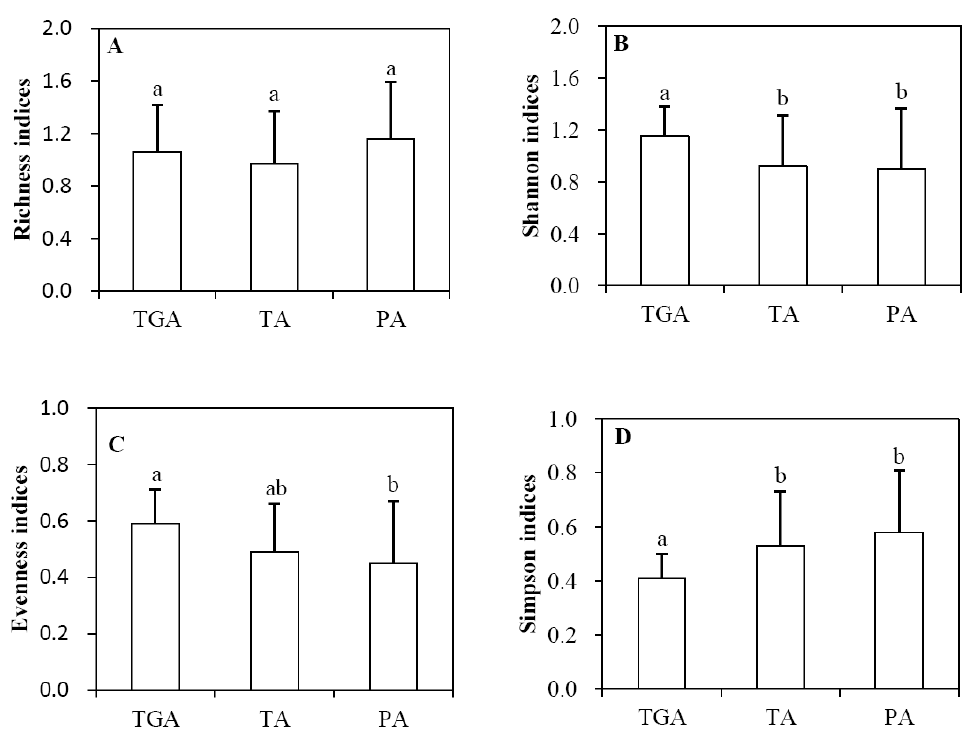
Figure 3. Comparison of the means of four diversity indices: richness ( A ), Shannon ( B ), evenness ( C ), and Simpson ( D ), and their standard deviations (error bars) at three sites subject to different levels of disturbance in the KGTA and YWNR, Beijing Municipality, China. Per diversity index, different superscripts indicate statistically significant differences between means ( p < 0.05).